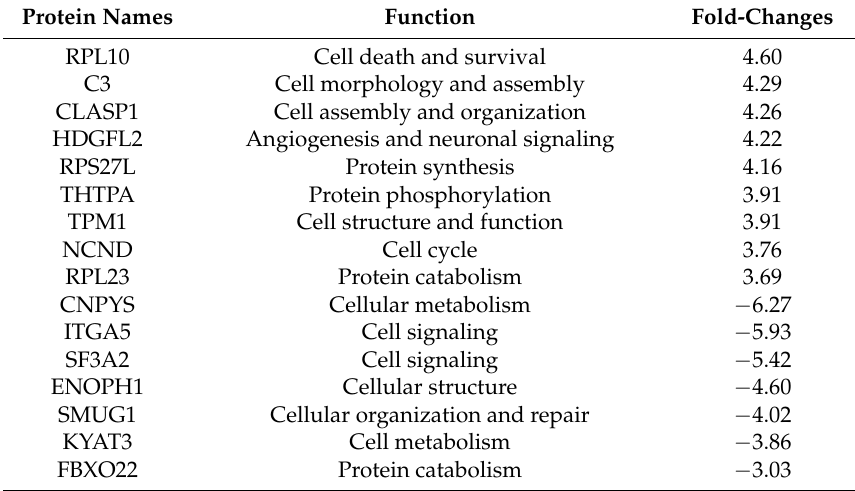
Table 3. Differentially expressed proteins identified by IPA in the ocular tissue in response to µ g vs. µ g + 1 g (fold change >2, FDR corrected p <